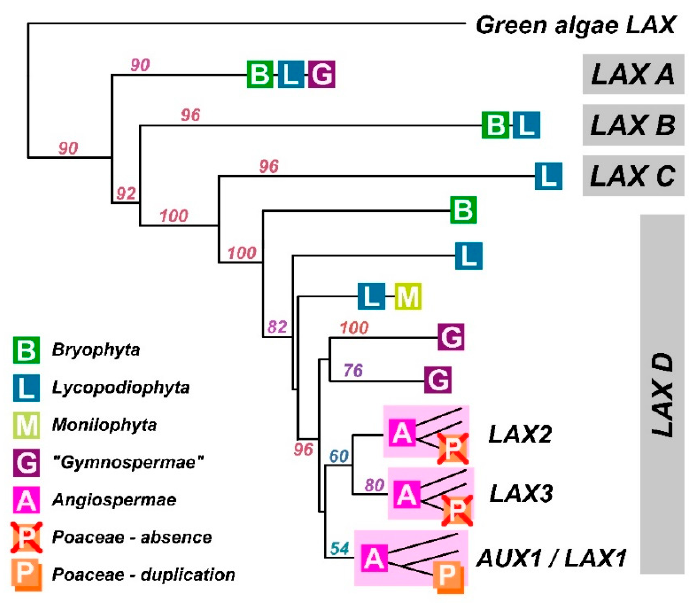
Figure 4. The AUX1/LAX phylogenetic tree. A summary of the maximum-likelihood phylogenetic analysis of nucleotide sequences using a GTR + G + I evolutionary model. Major taxonomic groups are depicted as letters. Node captions indicate bootstrap values.